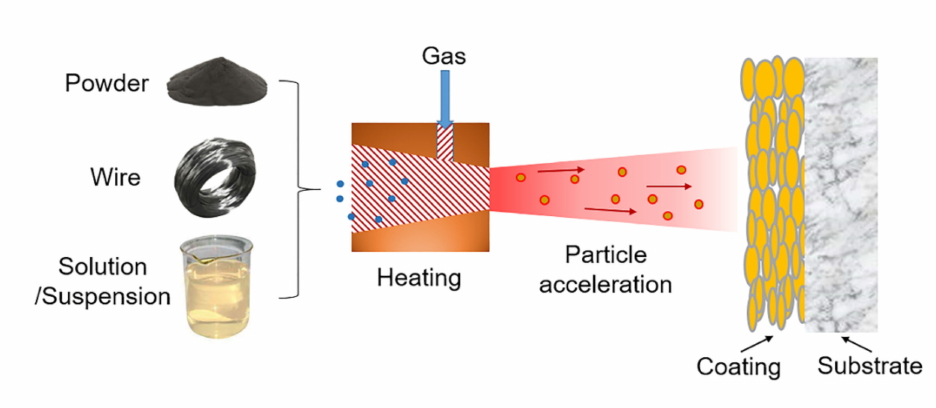
Figure 3. Schematic diagram of a thermal spray process. Controllable air flow and temperature meet di ff erent